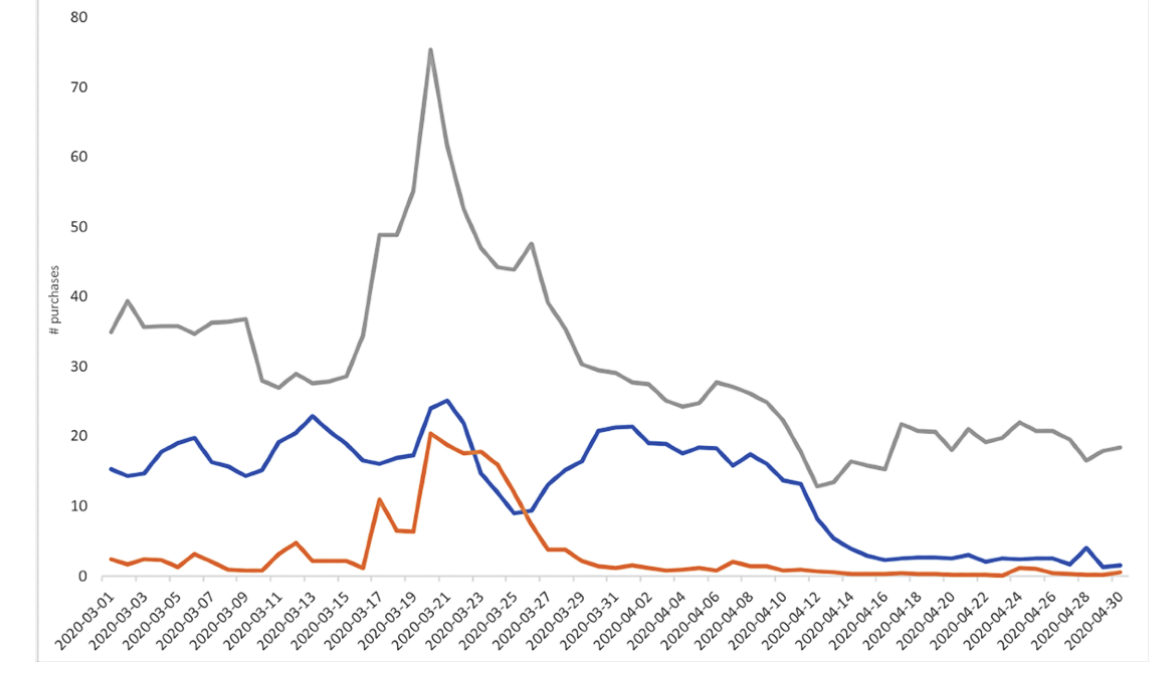
Figure 3. Amazon purchases of alternate therapies. Grey represents purchases of hydroxychloroquine, blue represents purchases of azithromycin, and orange represents purchases of